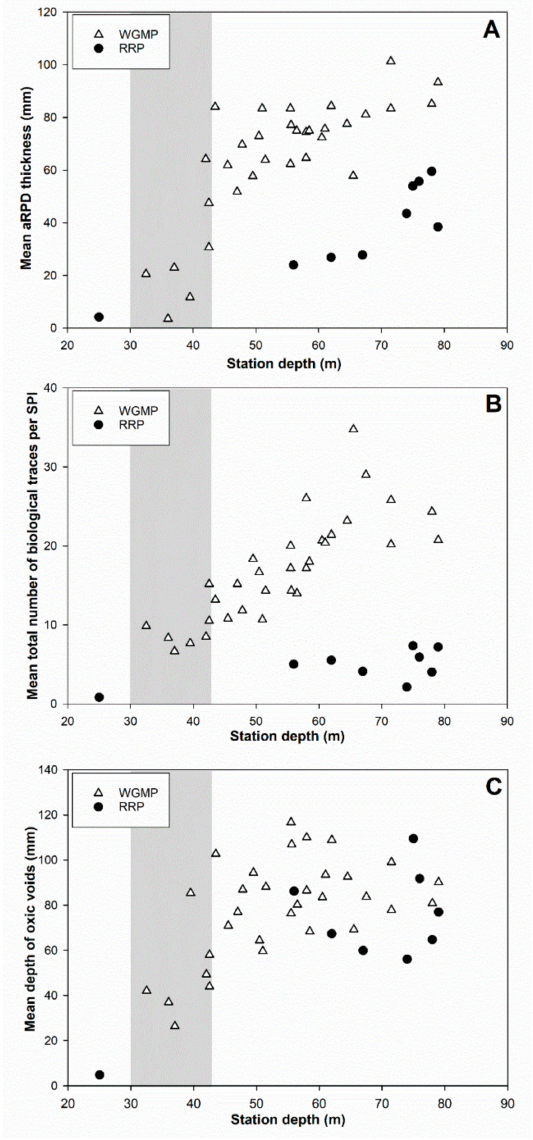
Figure 11. Relationships between station depth and mean main SPI characteristics in the WGMP and the RRP: aRPD thickness ( A ), total number of biological traces per SPI ( B ), and depth of oxic voids ( C ). Grey areas represent the proximal part of the WGMP (z < 42.5